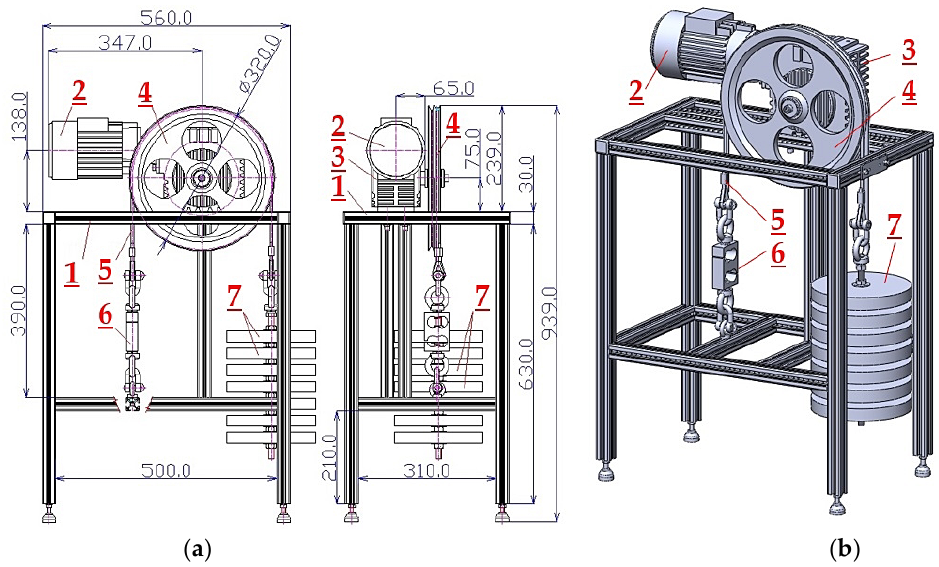
Figure 1. Structural design of the laboratory machine, recording the magnitude of the tensile force for the approaching side of the rope in sheave, using the software solutions ( a ) AutoCAD 2010, ( b ) SolidWorks 2012 Edition SP05. ( 1 —machine frame, 2 —electric motor, 3 —worm gearbox, 4 —rope sheave, 5 —steel rope, 6 —force sensor, 7 —weight).